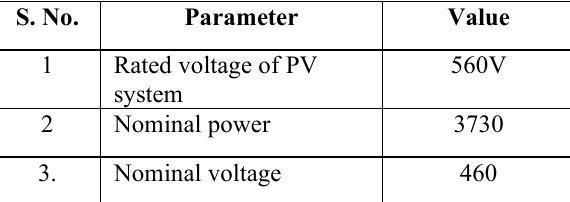
Table 6. Specifications of the PV sys and induction